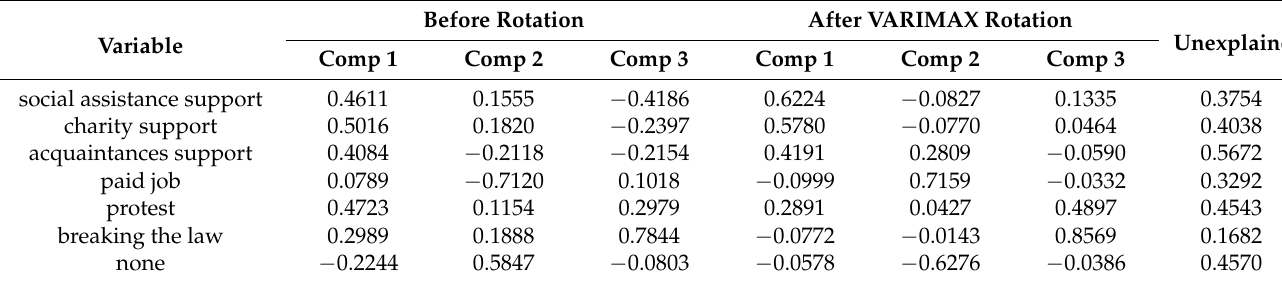
Table 3. Principal component analysis of the actions undertaken provided insufficient old-age pension levels. Variable